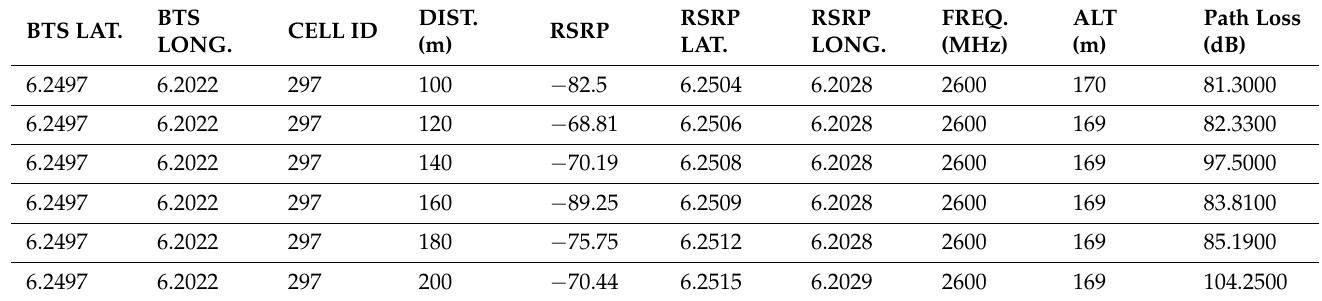
Table 1. The acquired signal dataset and the consistent features in one of the studied locations.